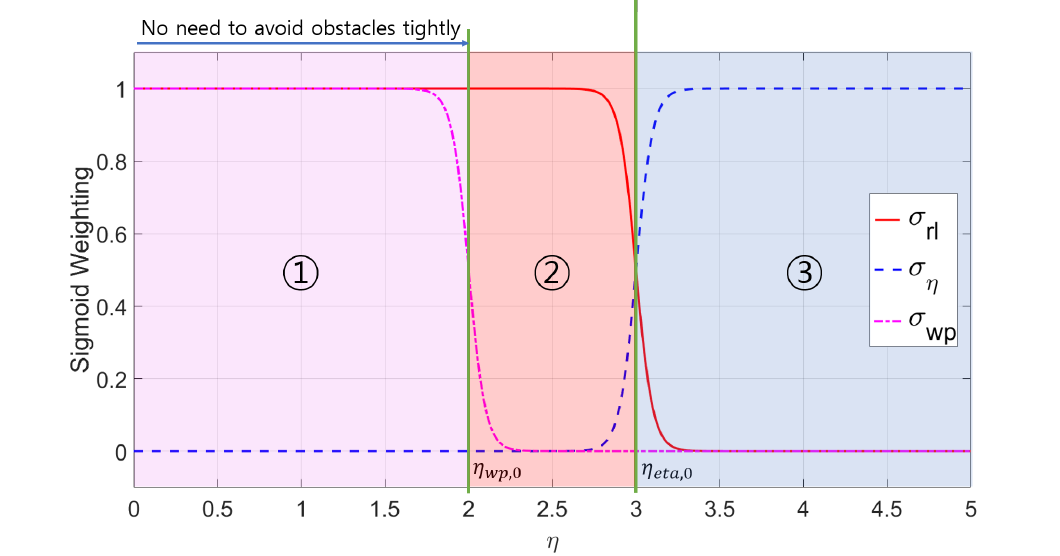
Figure 6. Sigmoid weighting with respect to the